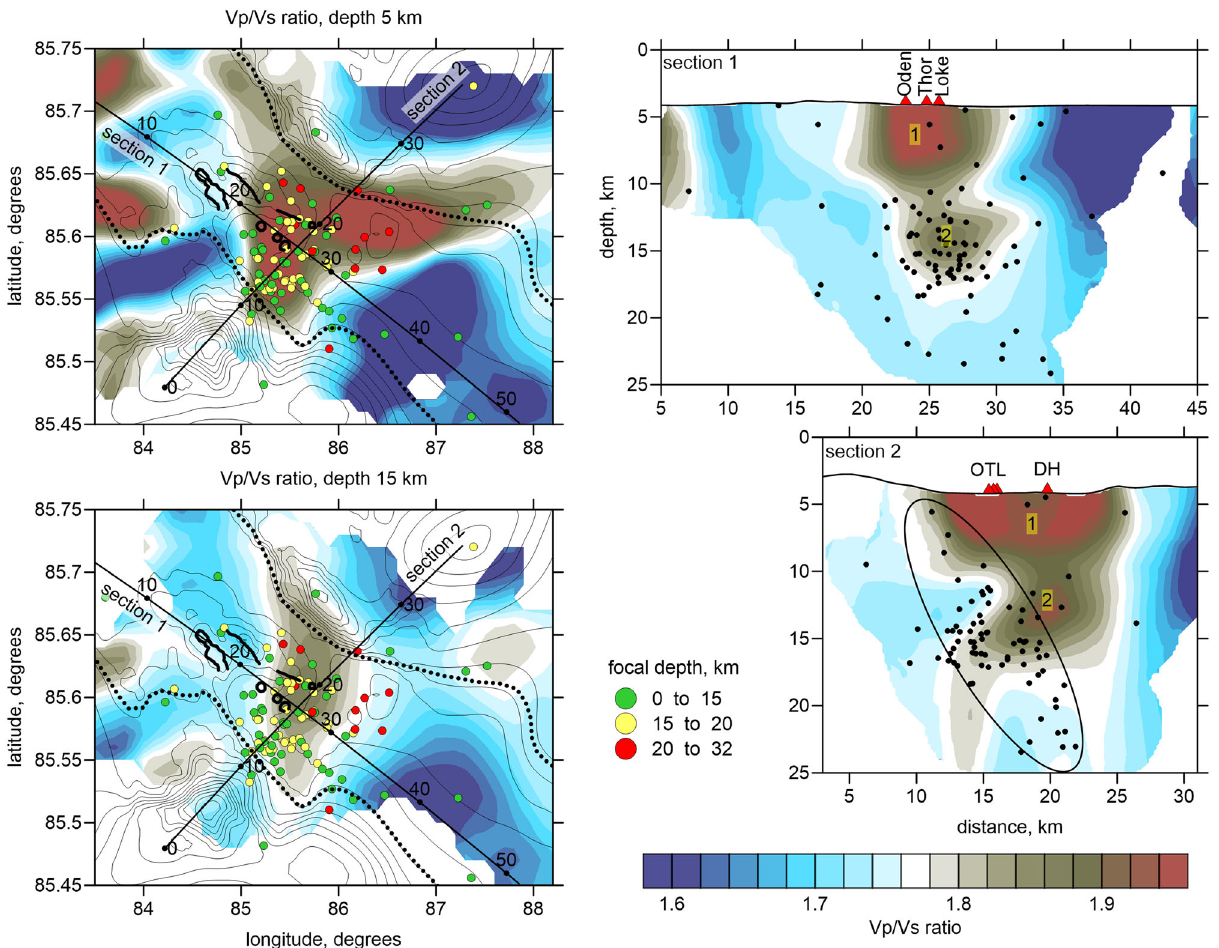
Fig. 2 The Vp/Vs ratio distributions in two horizontal and two vertical sections. The colored dots in the horizontal sections indicate the locations of earthquakes arranged by depth. The dotted lines indicate the border of the rift valley. The major volcanic structures are highlighted with solid black lines. The bathymetry is represented by thin contour lines (every 100 m). In the vertical sections, the black dots show the locations of events at distances less than 7 km. The red triangles depict the volcanic structures (e.g., OTL — Oden, Thor, Loke; DH — Duque ’ s